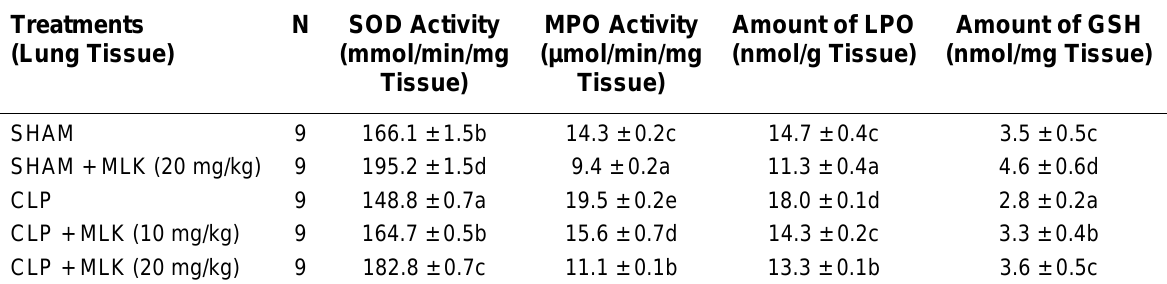
Effects of MLK Treatments on Changes in Activities of MPO and SOD, and with Levels of LPO and GSH in Lung Tissues of Rats Treatments N SOD (Lung Tissue)